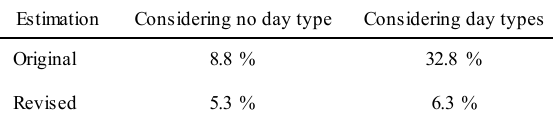
Table 4. Relative Error Rate